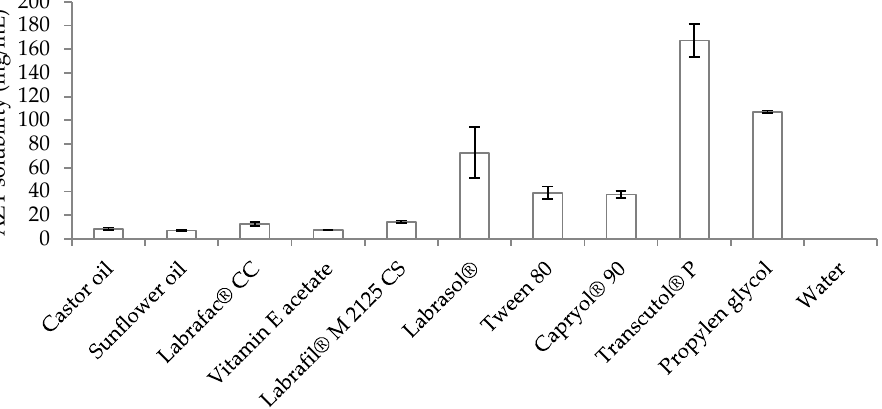
Figure 1. Solubility (mg/mL) of AZT in various types of oils, surfactants and co-surfactants at +25 °C. Data are expressed as means ± SD, n = 3.